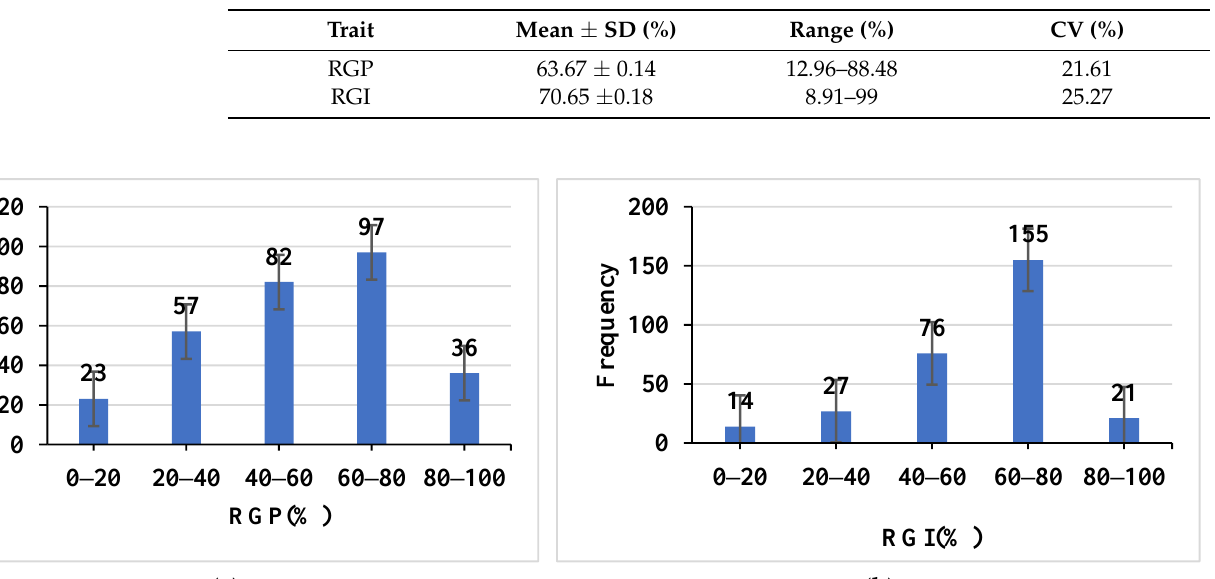
Figure 2. Frequency distribution of RGP ( a ) and RGI ( b ) among the 295 japonica rice accessions. Table 3. Specific information of 21 high salt tolerance accessions.